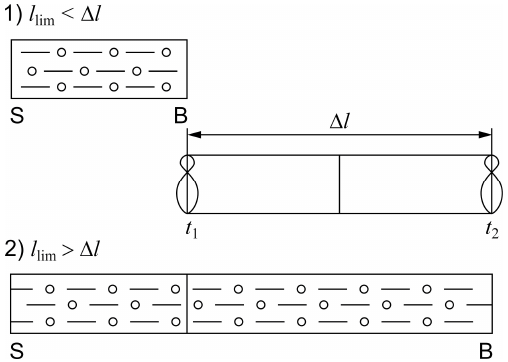
Figure 3. Schematic diagram of measuring the characteristics of milk flow: (S) stern part of the milk plug, (B) bow part of the milk plug, ( Δ𝑙 ) hose arc length, ( l lim ) the limiting length of the milk plug, ( 𝑡 (cid:2869) ) and ( 𝑡 (cid:2870) ) time moments of entry and exit of the bow of the plug from the